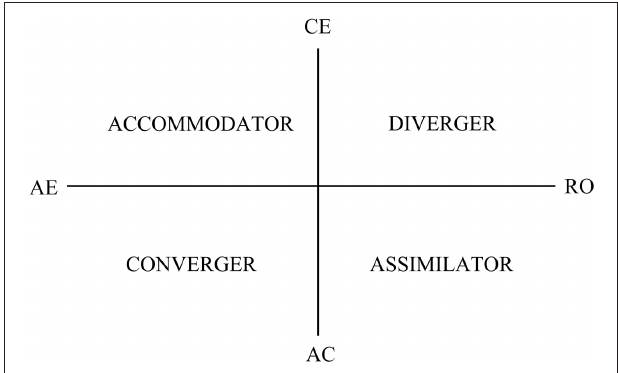
FIGURE 1 | ELT learning modes and styles; prehension in the vertical axis and transformation in the horizontal